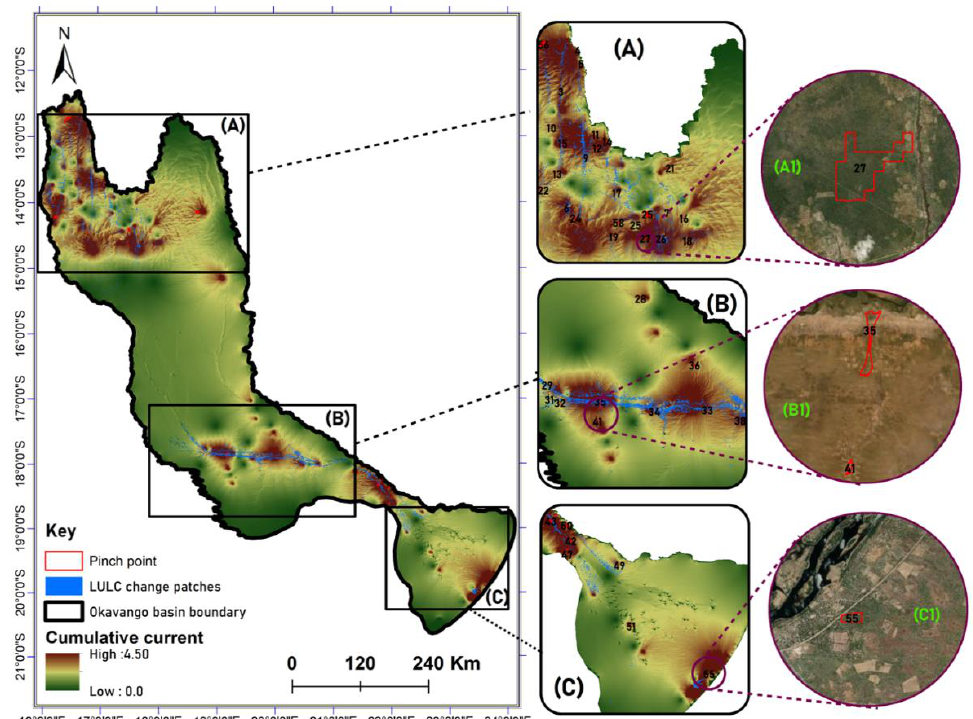
Figure 5. The map shows the cumulative current map and pinch points for Category A transitions (from natural to artificial classes). The subfigures ( A – C ) highlight areas of the basin with high cumulative current density and subfigures ( A1 – C1 ) indicate locations of selected pinch points overlaid on satellite images to show how pinch points appear on the ground.